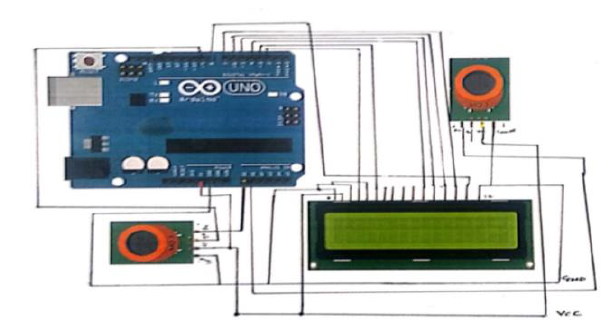
Fig. 1. Schematic diagram of the proposed prototype